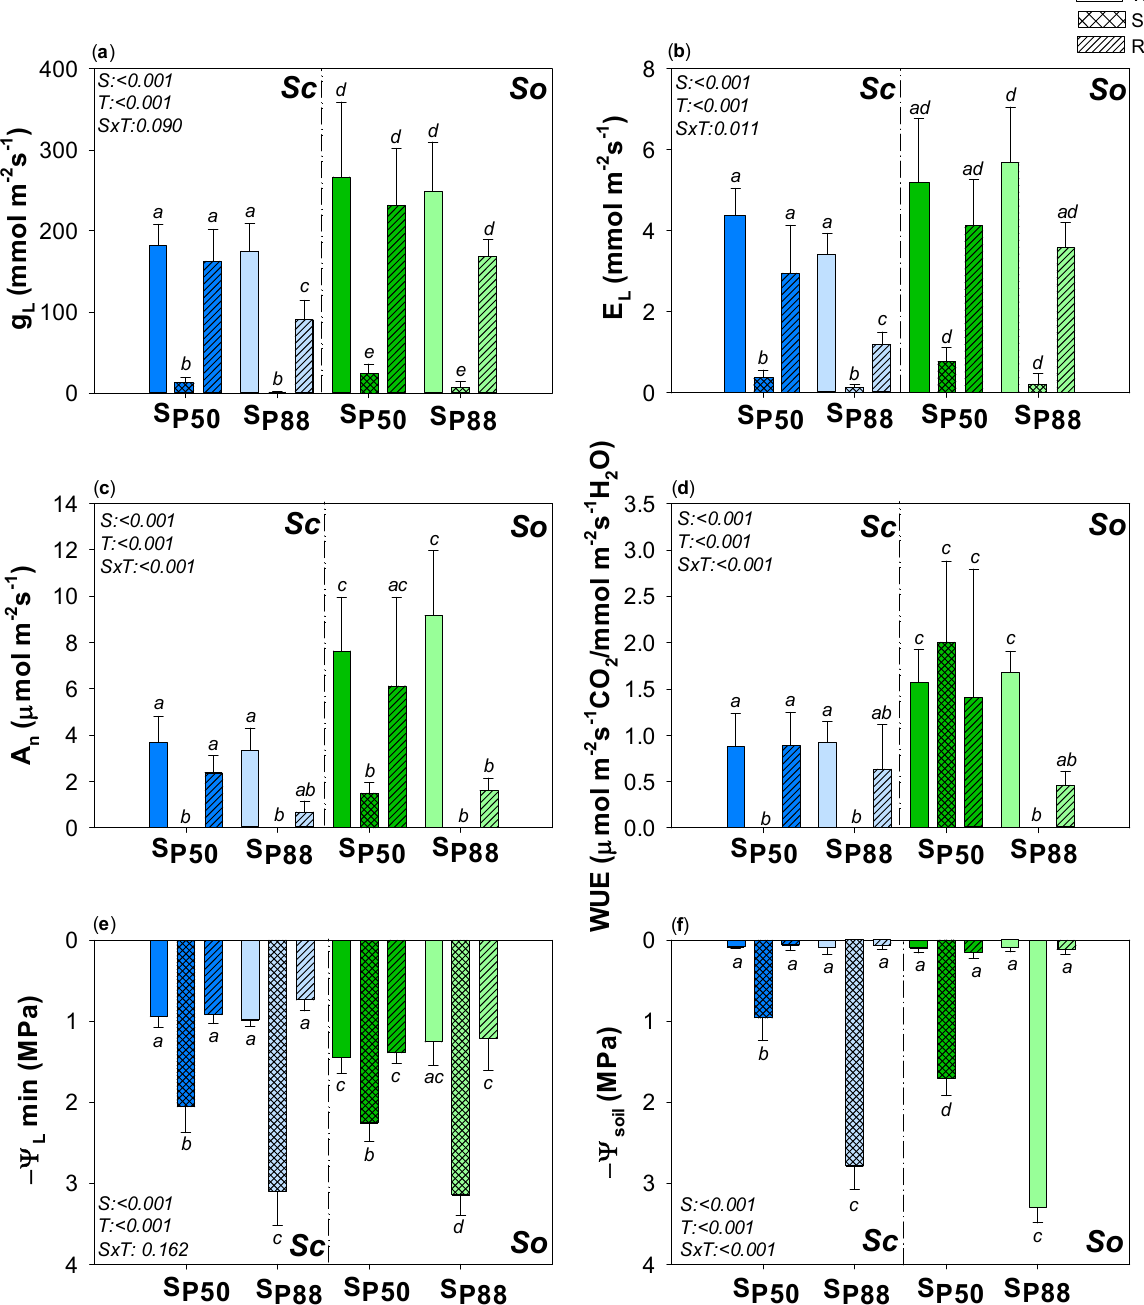
Figure 1. Effect of experimental treatments on gas exchange and water potential. Mean ± SD ( n = 6) values of: ( a ) midday leaf conductance to water vapor, g L ; ( b ) transpiration rate, E L , ( c ) photosynthetic rate, A n , ( d ) water use efficiency, WUE, ( e ) leaf water potential, Ψ L and ( f ) soil water potential, Ψ soil as recorded in well-watered (W, none pattern), water–stressed (S, slanting dash) and re-irri- gated (Rec, mesh dash) plants of S. ceratophylloides ( Sc , blue columns) and S. officinalis ( So , green columns) submitted to two different water stress levels, i.e., S P50 and S P80 (for details, see the text). p values as obtained by the two-way ANOVA analysis are reported. Different letters indicate statisti- cally significant differences between groups. Applied drought treatments strongly affected the relative water content of leaf, stem and root samples of the two Salvia species (Figure 2). However, after the rewatering, a full recovery of root RWC values was recorded, including when a severe water stress was experimented by Sc and So samples. This recovery was coupled to new roots growth, as observed in both species (data not shown). A different behavior was observed in the stem and leaf samples of the two Salvia species, especially in response to severe drought treat- ment. Water stress inducing 50% loss of leaf hydraulic conductance (K L , i.e., S P50 ) did not affect the leaf and stem cell ability to recover water content in Sc and So samples and no permanent damage was recorded after rewatering in the two Salvia species. By contrast, experiencing about 88% loss of leaf hydraulic conductance (i.e., S P88 ), only a partial recov- ery of leaf RWC values in Sc as well as So samples was recorded. The inability to recover the leaf water content was likely induced by a residual 20% loss in cell rehydration capa- bility, as recorded in the two species even after rewatering. However, leaf Sc samples were more severely affected by S P88 treatment. In accordance, S P88 leaf samples of Sc showed higher leaf cell membrane damages (i.e., REL ~ 70% versus 40%, respectively) and higher